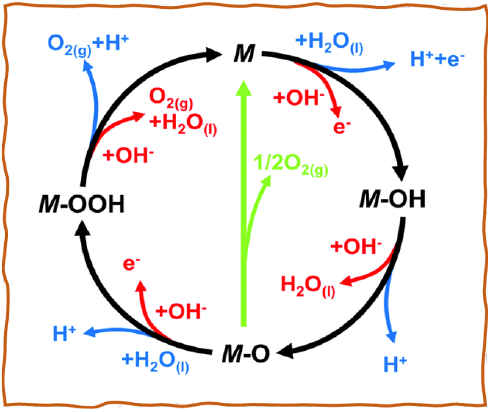
Figure 4. The OER mechanism for acid (blue line) and alkaline (red line) conditions [58]. Reprinted with permission from Ref. [58]. Copyright © 2017 The Royal Society of Chemistry.